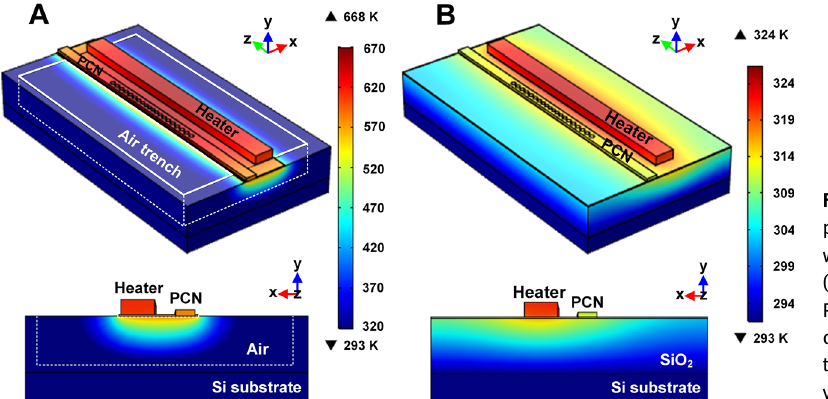
Figure 4: Simulated thermal fields of the photonic crystal nanobeam (PCN)